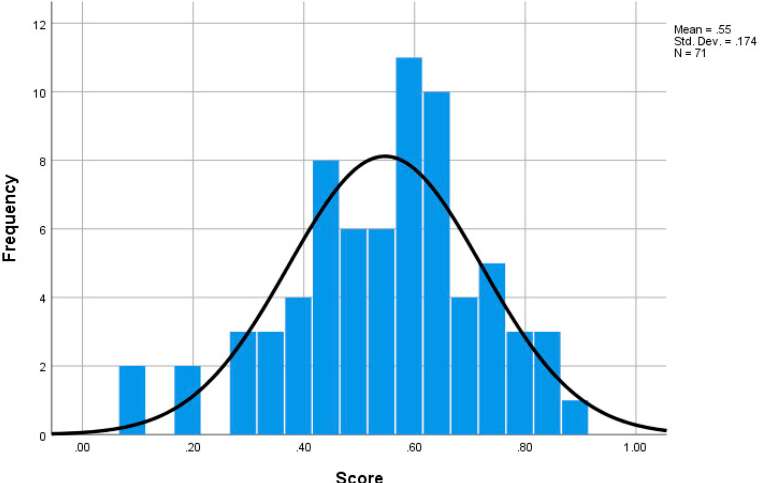
Figure 2. The histogram of frequency counts. The mean score is 0.55 (SD = 0.174). Cronbach’s alpha is 0.827.